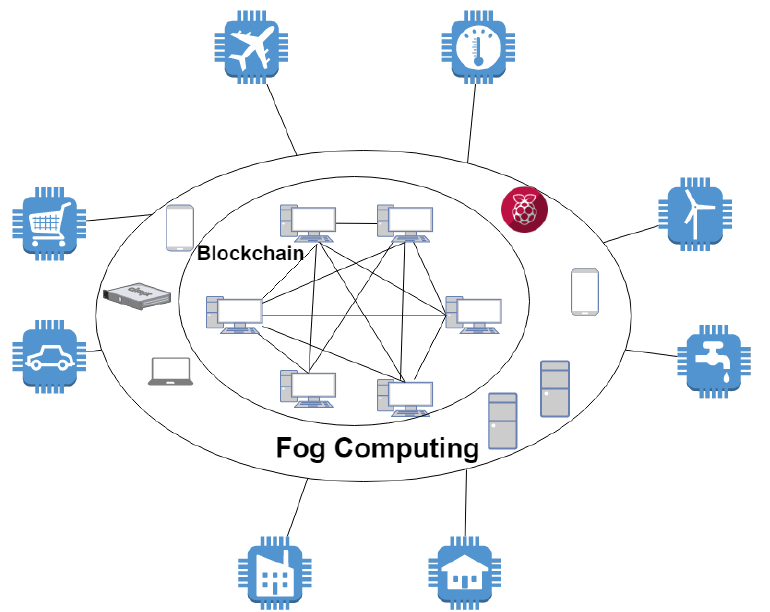
Figure 9. Fog with